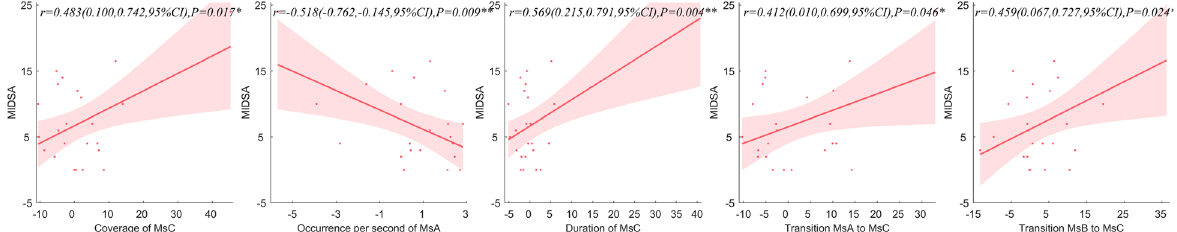
Fig.5 The correlation between microstate parameters and MIDAS scores of patient group. A . The correlation between MIDAS and coverage of MsC. B . The correlation between MIDAS and occurrence per second of MsA. C . The correlation between MIDAS and duration of MsC. D . The correlation between MIDAS and transition MsA to MsC. E . The correlation between MIDAS and transition MsB to MsC. The correlation was analyzed by the residuals of microstate parameters and MIDAS with age and sex as covariates. Ms, microstate, CI, confidence intervals; ** P < 0.01, * P <